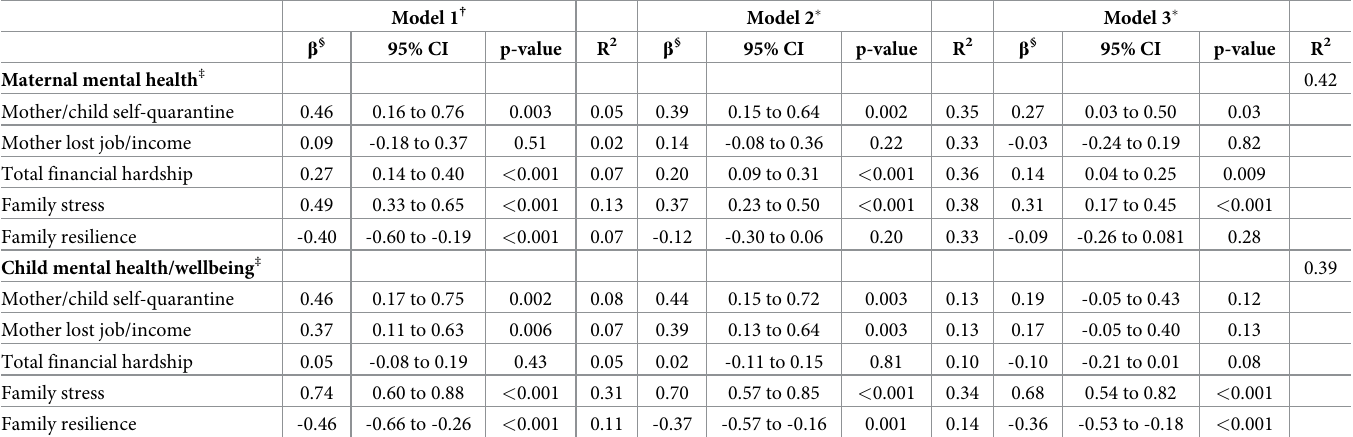
Table 4. Associations between COVID-19 impacts and maternal and child mental health